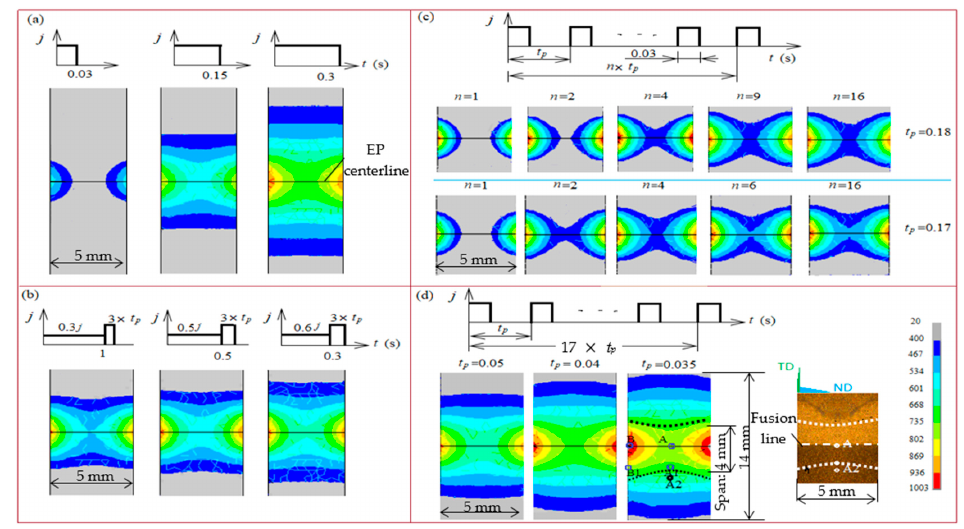
Figure 3. Temperature contour maps for ( a ) single EP; ( b ) preheat EP; ( c ) various t p s of EP and ( d ) various t p s of EP subjected to accelerated cooling. The temperature histories at the monitored points are shown in Figure 4. After con- siderable pulses, the temperature converges dynamically.